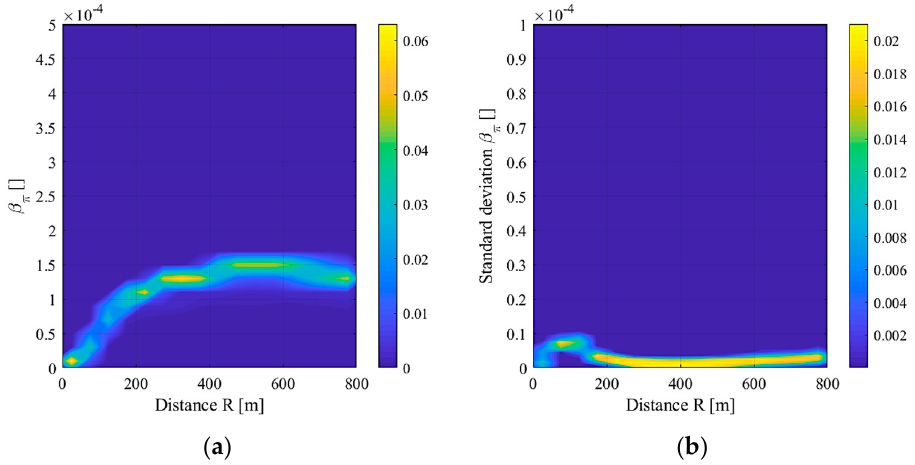
Figure 4. Probability density map of backscattered coefficient amplitude ( a ) and standard deviation ( b ). The “safe” region, represented by the yellow-green-light blue colors, symbolizes the